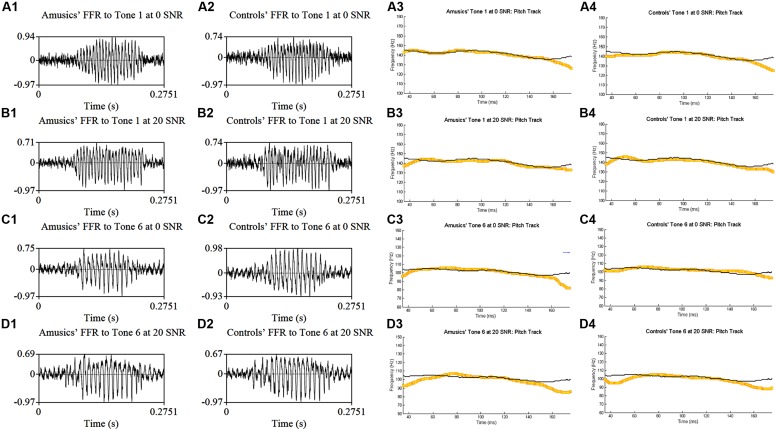
Grand average waveforms of amusics’ (A1–D1) and controls’ (A2–D2) FFRs to Cantonese Tone 1 and Tone 6 heard in babble noise (SNR = 0 and 20 dB), and the corresponding pitch tracks (A3–D3, A4–D4).